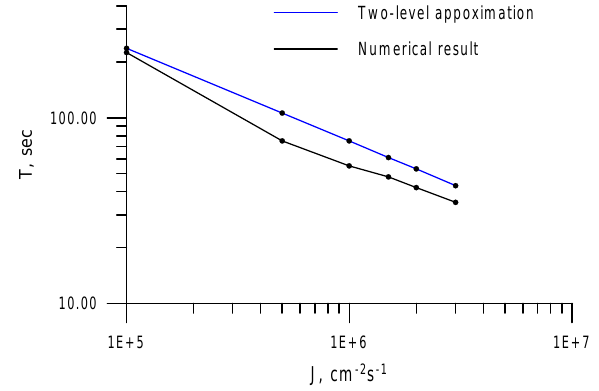
Fig. 2. Dependence of period of relaxation oscillations on the inten- sity of the energetic particle source. Results from simplified “two- level approximation” model and from numerical analysis of the full system Eqs. (1) and (2) are presented. The same system parameter values (except the source intensity) as in Fig. 1 were